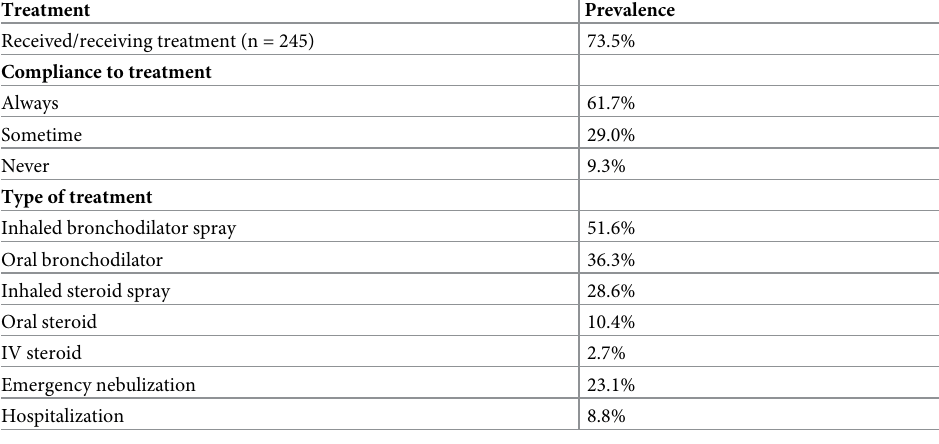
Table 6. Treatment of options explored by the people for respiratory allergies in Qassim, KSA, September– December